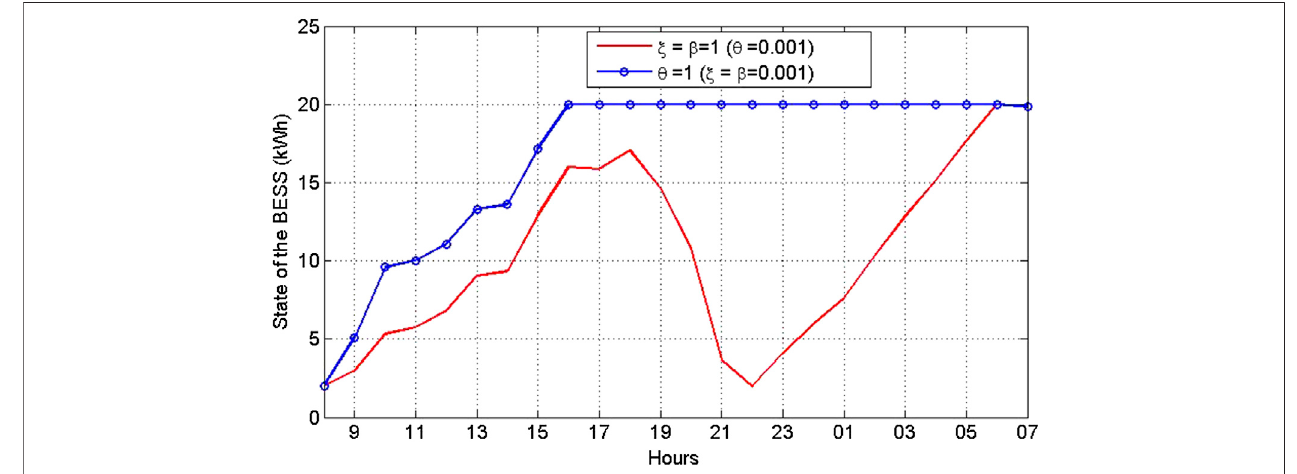
FIGURE 5 | Variation of the energy storage state according to the two scenarios.